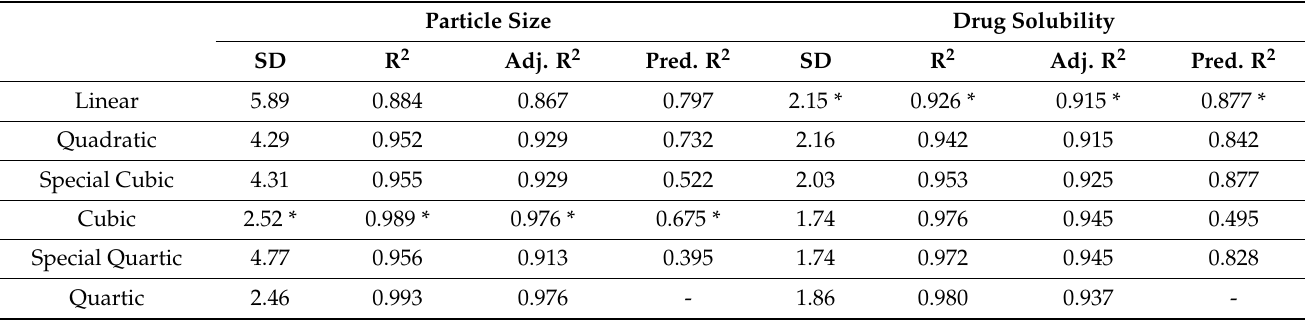
Table 3. Model summary statistics for glimepiride-loaded SNEDDS on droplet size and drug solubil- ity. Particle Size